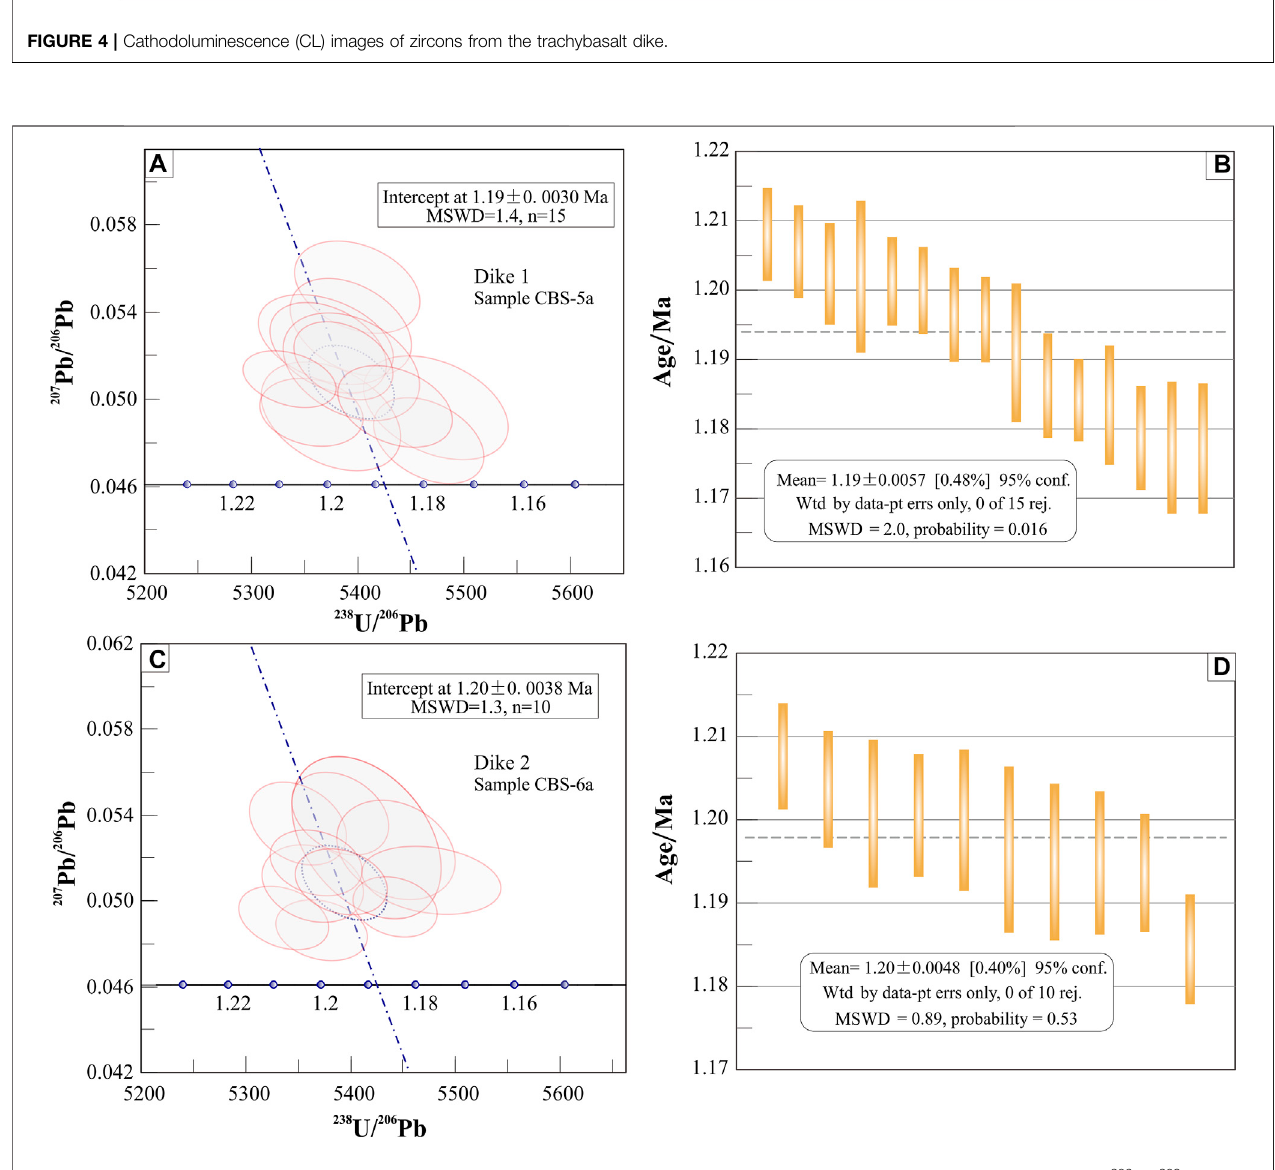
FIGURE 5 | (A, B) Tera – Wasserburg concordia diagram for individual zircons determined by LA-MC-ICP-MS from the trachybasalt dike; (C, D) 206 Pb/ 208 Pb weighted average age of zircons.